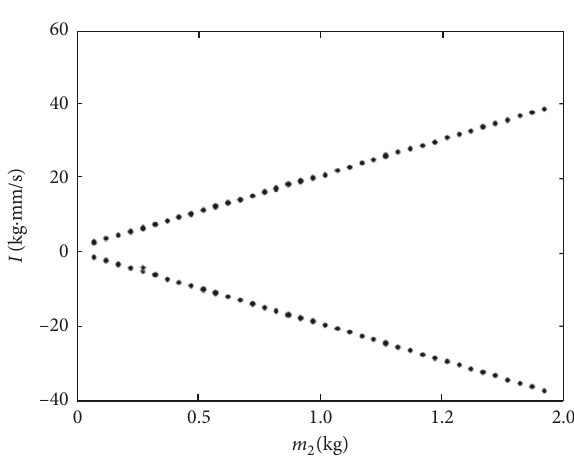
0.2mm. (b) j (cid:29)